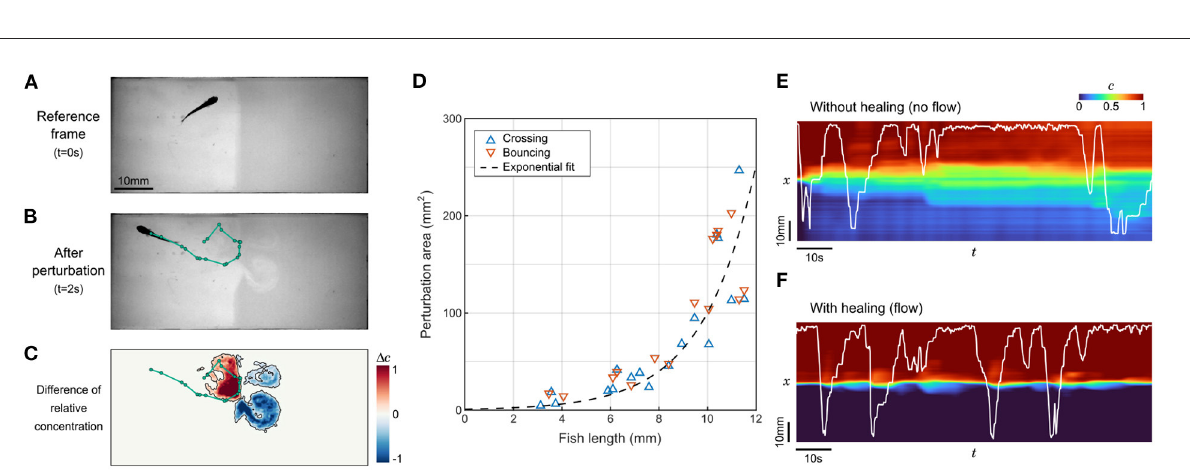
FIGURE3 Perturbation of the interface by fish movements. (A,B) Sample frames before and after a 2s trajectory of a juvenile zebrafish bouncing on the interface. The trajectory is highlighted in green. (C) Field of the difference in relative contentration for the same short trajectory. The perturbed area is contoured in black. (D) Perturbation area as a function of fish length for 33 randomly selected events where different fish either passes through the interface ( n 18) or bounces onto it ( n 15). (E,F) Relative concentration averaged over y as a function of time. The position of the = = same juvenile zebrafish is displayed in white. Without flow, the successive swim movements rapidly spread the compound in the whole chamber (E) , while under flow the interface self-heals to keep a controlled separation (F)